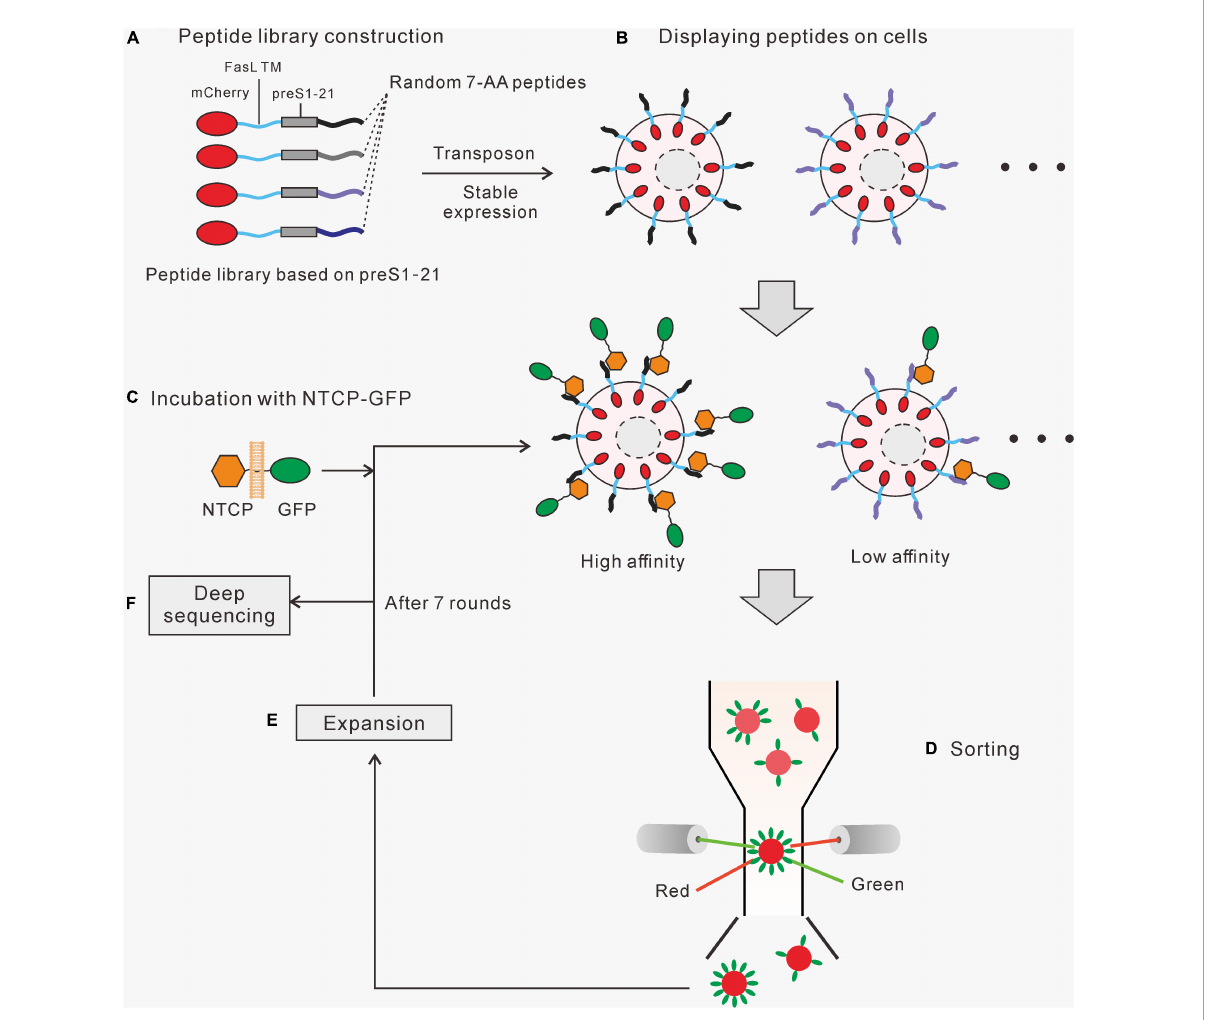
FIGURE1 The strategy of the cell surface display system. (A) A randomized peptide library is constructed based on preS1 aa2-21. The fusion protein contains a mCherry, a FasL transmembrane domain, a preS1 aa2-21, and a 7-aa randomized peptide. (B) A cell library displaying the fusion proteins was created using the Sleeping Beauty transposon system. (C) The cell library was incubated with cell membrane segments carrying NTCP-GFP, and those cells expressing high-affinity peptides would bind more NTCP-GFP. (D) Red fluorescent (mCherry) cells with relatively higher green fluorescence (GFP) were sorted by flow cytometry. (E) The selected cells were amplified before moving on to the next round of the screening process. (F) Genomic DNA was extracted from the final enriched cells. Fragments containing target sequences were amplified by PCR and sequenced to identify the enriched